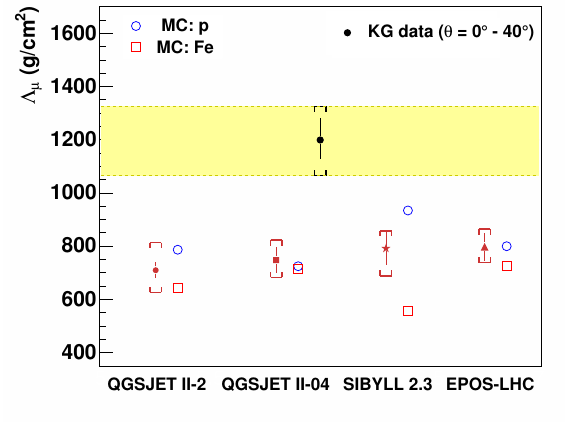
Figure 3. Muon attenuation length measured with the KASCADE-Grande experiment (upper point) compared with predictions (lower points) of QGSJET-II-02 (from [12]) and post- LHC high-energy hadronic interaction models using our fitted composition models. Estimations for pure protons and iron nu- clei (spectrum E − 3 ) are also shown (blue circles and red squares, respectively). The total uncertainty (statistical and systematic er- rors added in quadrature) are shown with squared brackets. Error bars represent statistical uncertainties (see [12] for a description of the